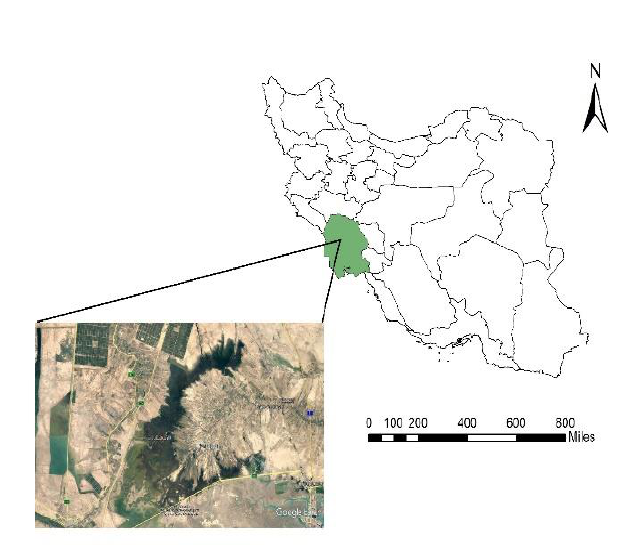
Figure 2. The Study area of